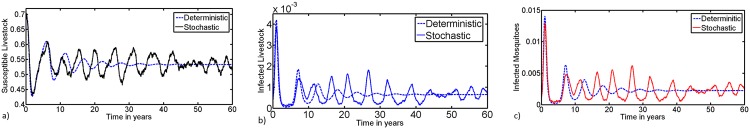
Realization of the RVF host-vector stochastic model and its deterministic counterpart.The trajectories of the deterministic counterpart are generated by integrating the mean field Eq (10). The values of the parameters in years are as follows: q1 = 0.2, μ1 = (1/20) ∗ 360, μ2 = 1/8, β12 = 0.194, β21 = 0.128, ϵ2 = (1/4) ∗ 360, α′ = α = 256, m0 = 1.5 and R0 = 1.8809, and their description and sources is given in Table 1.